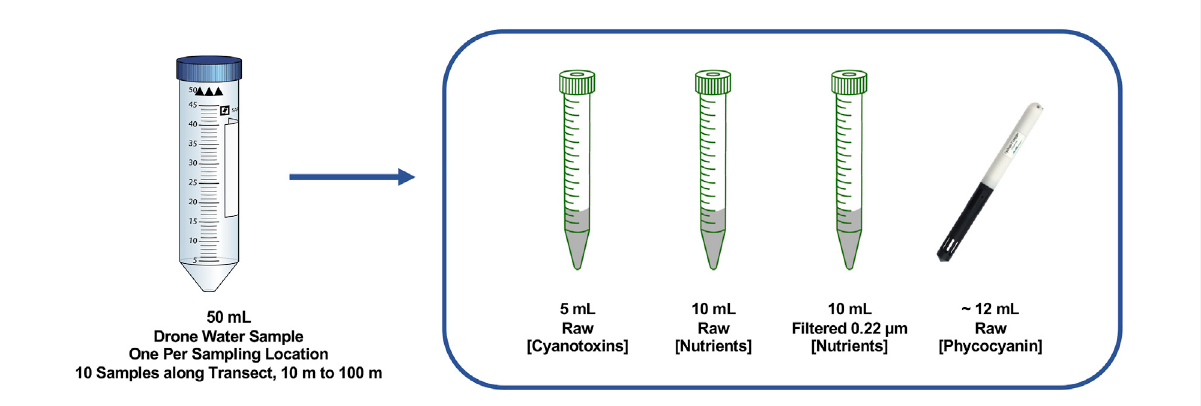
FIGURE 3 Schematic illustrating how samples were processed for each 50 ml drone water sample. Aliquots were made for toxin analysis (5 ml), nutrient analysis(10 ml),and fi ltratenutrientanalysis( < /=0.45 µm)(10 ml),forall fl ights.Onemilliliterwasaliquotedfor fl owcytometry(1 ml)fromLakeAnna collections (Flight 07 – Flight 18). The remaining volume in the 50 ml collection tube was adjusted to 12 ml and used for phycocyanin (PC) readings with the Cyclops-7 sensor from Turner Designs, Inc. (Sunnyvale, CA) on the day of collection. PC data was recorded with the Precision Measurement Engineering data logger (Vista,